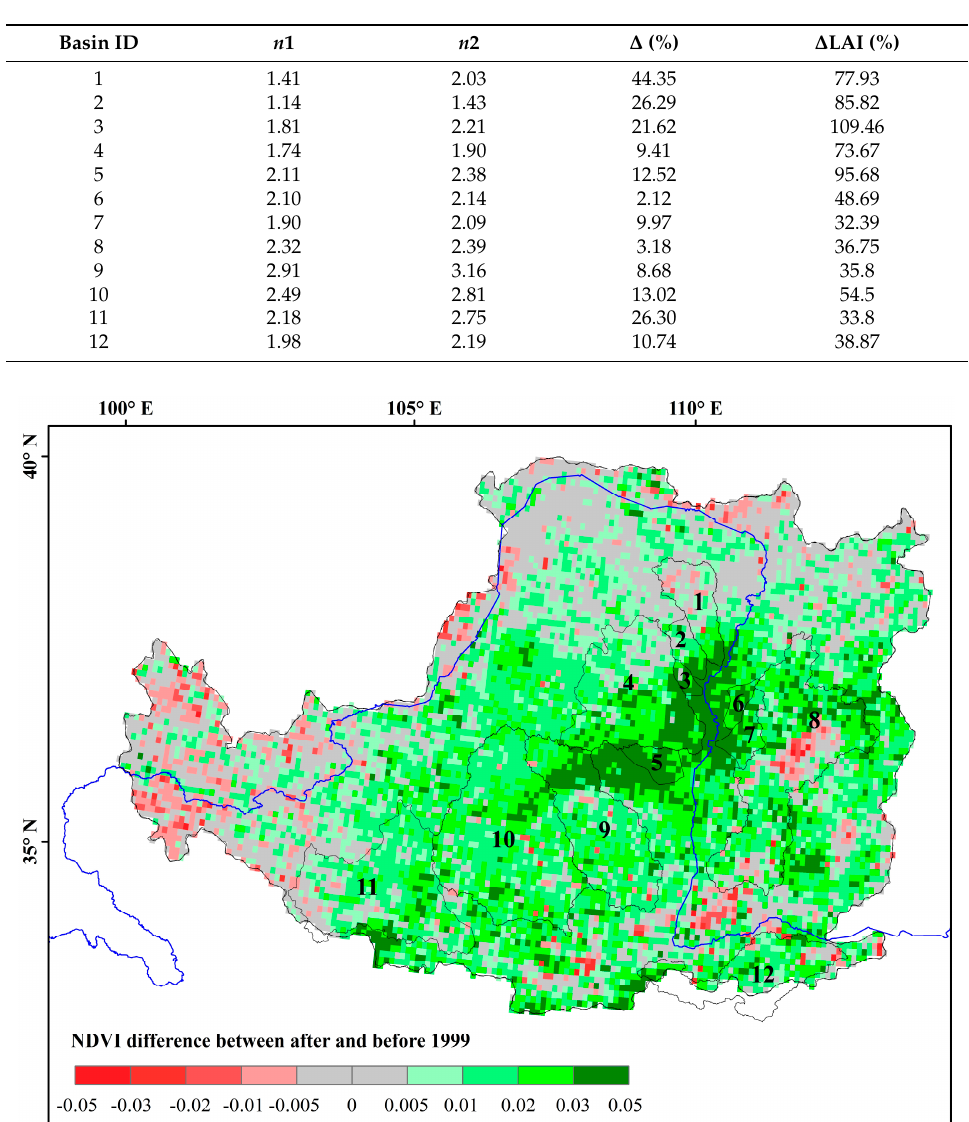
Table 5. Change in parameter n and LAI before and after 1999.